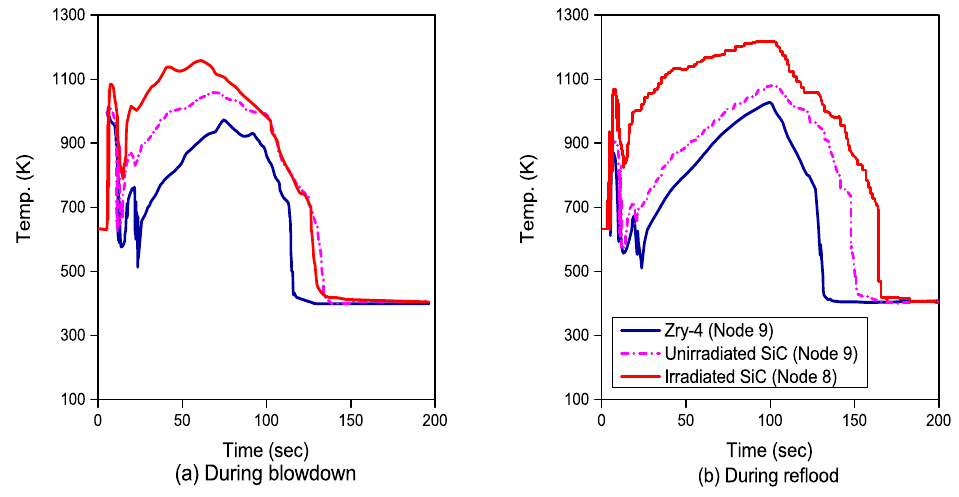
Figure 4. Outer peak cladding temperature.